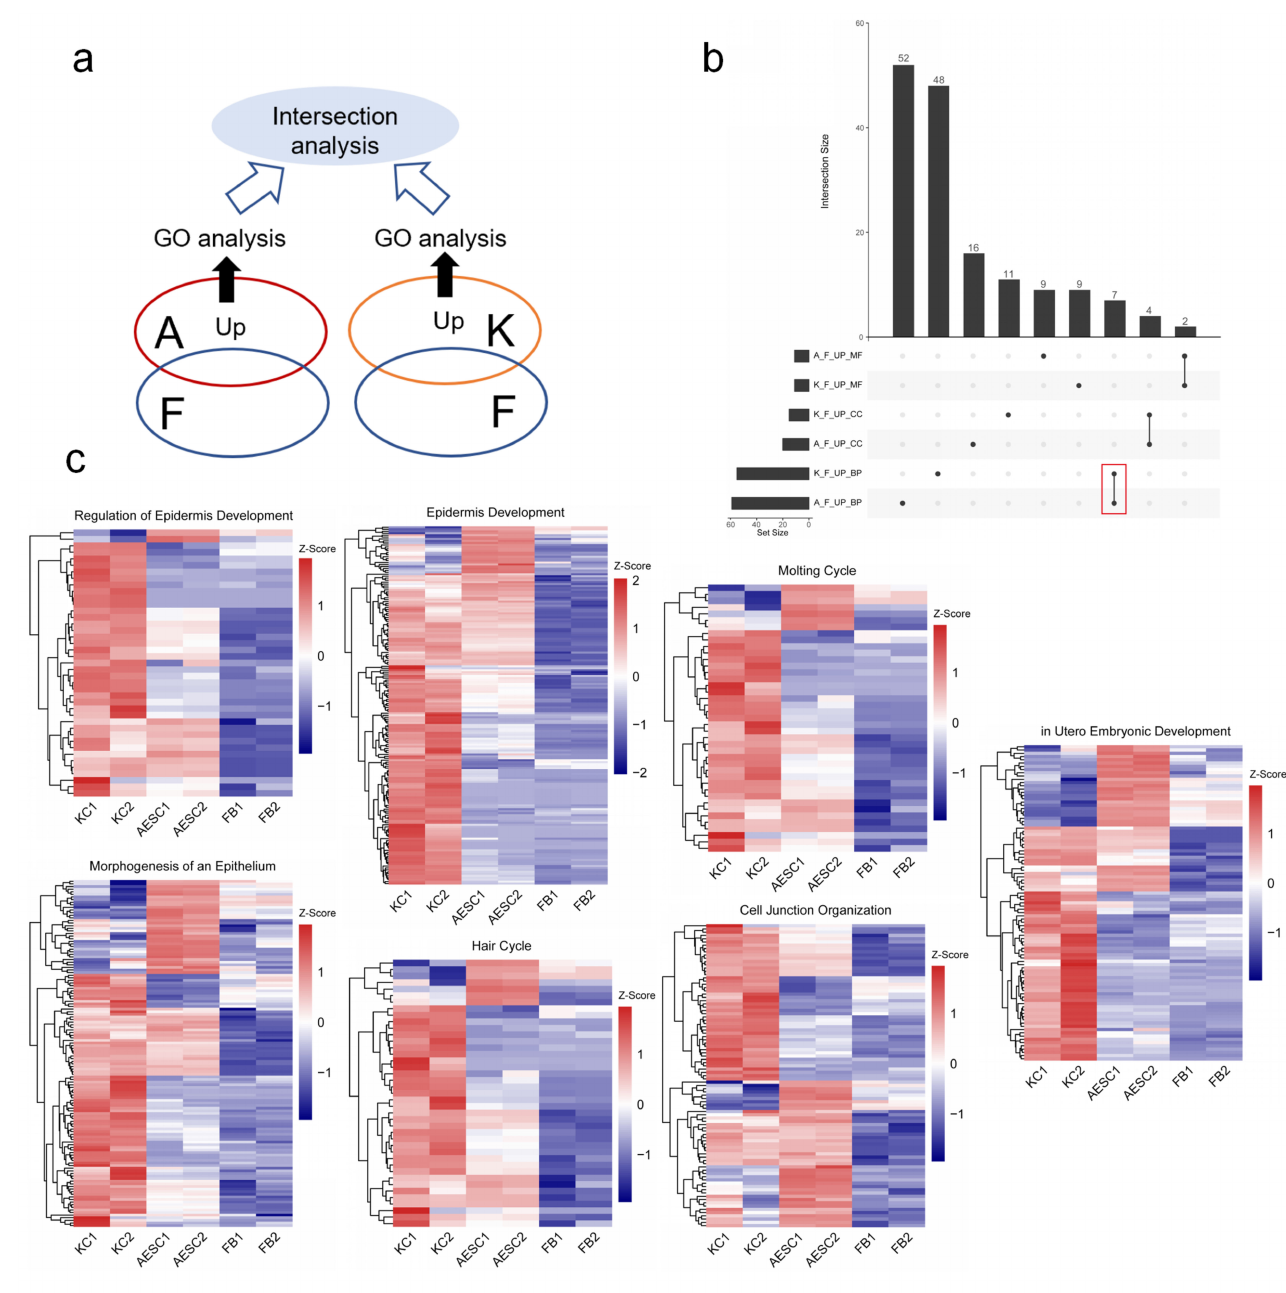
Figure 1. Transcriptomics reveals similarities between amniotic epithelial stem cells (AESCs) and keratinocytes (KCs) in epidermis-associated biological processes. ( a ) Strategy for similarity analysis of transcriptomics. Upregulated and differentially expressed genes in AESCs (A) and KCs (K) were screened by comparing them with fibroblasts (F) for further gene ontology (GO) analysis and intersection analysis; ( b ) Intersection analysis of involved GO terms of highly upregulated genes in AESCs (A) and KCs (K) compared to those in fibroblasts (F) revealed 7, 4, and 2 terms associated with biological process (BP), cellular component (CC), and molecular function (MF), respectively. ( c ) Heatmaps of genes involved in seven intersected BP terms between AESCs and KCs. F & FB, fibroblast; A & AESC, amnion epithelial stem cell; K & KC,